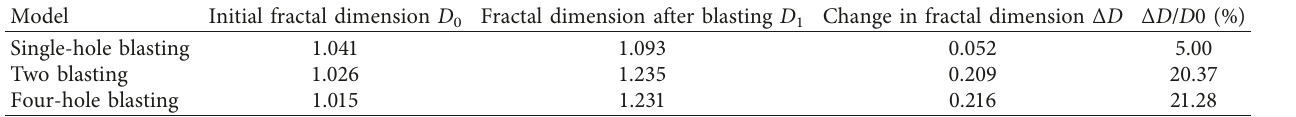
Table 3: Calculation results of crack fractal dimension.